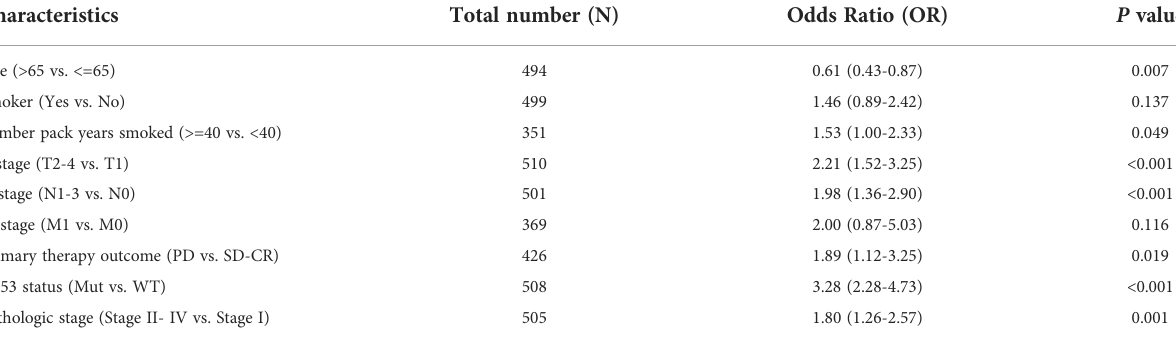
TABLE 2 Relationship between CDCA4 expression and clinicopathological characteristics of TCGA database by logistic regression analysis.